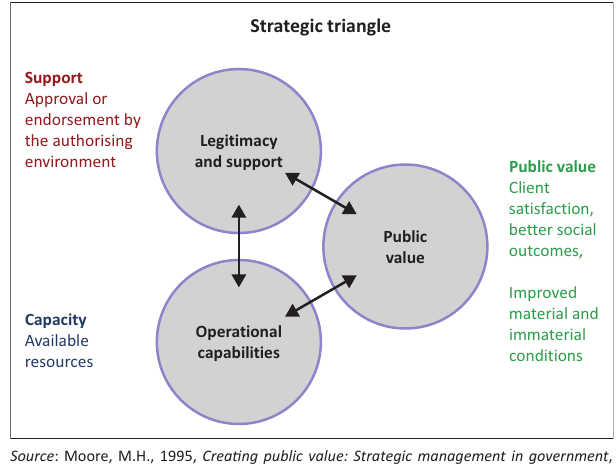
FIGURE 1: The strategic